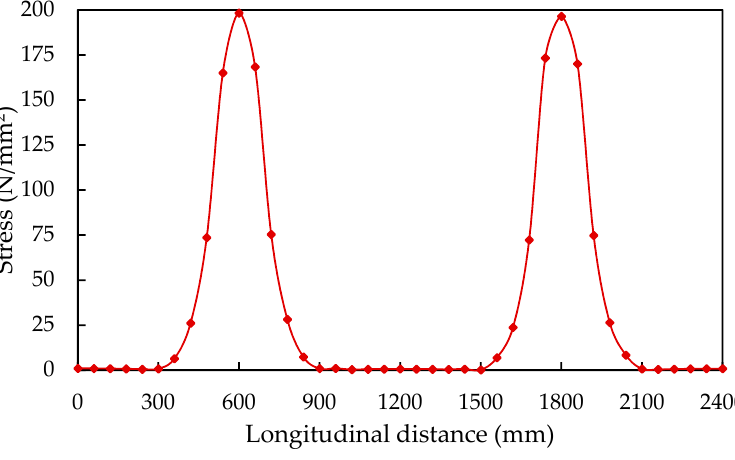
Figure 13. Stress variation in the longitudinal steel bar.